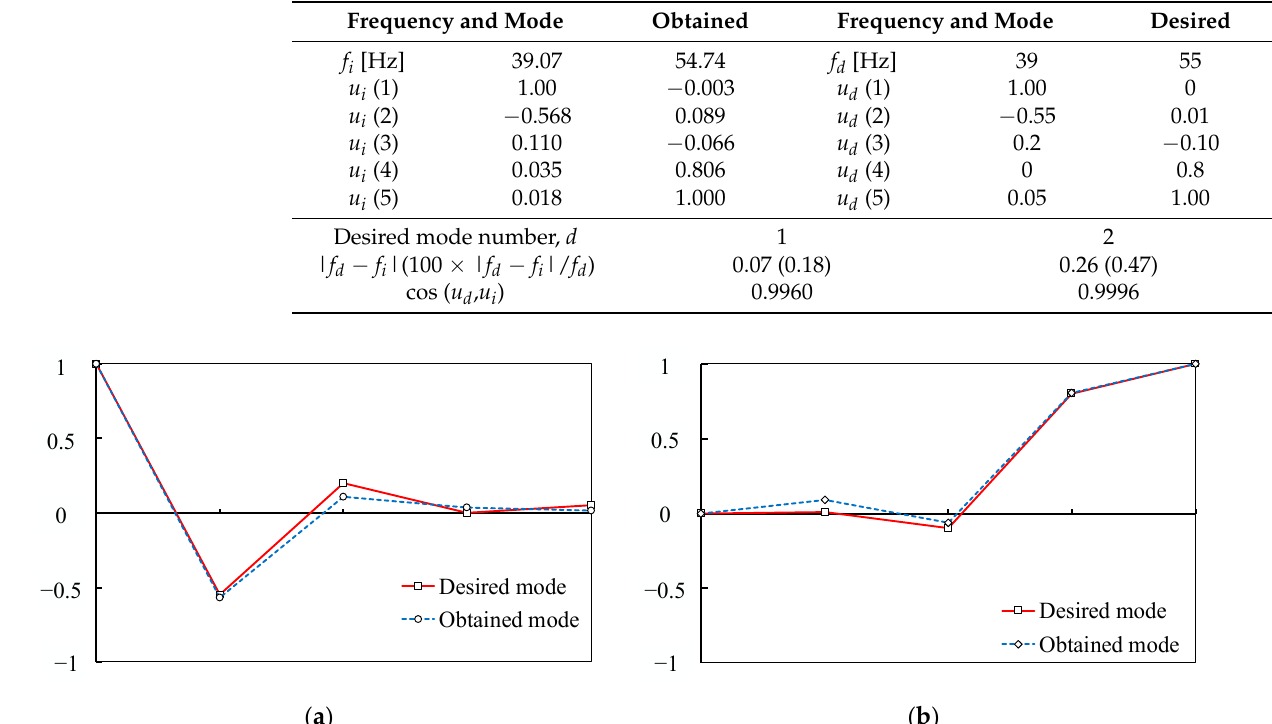
Table 20. Comparison of natural frequencies and mode shapes.